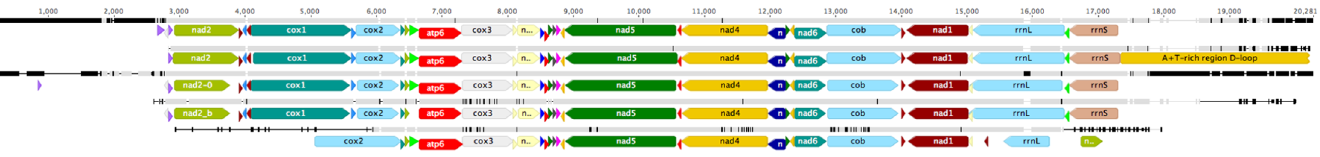
Fig 5. Comparison of the mitogenome sequences of H . axyridis obtained in this work with H . axyridis (KR108208) [38] using standard parameters in MAFFT v7.017 [34]. The KR108208 has 16,387bp, 13 PCGs, 20 tRNAs (missing trn I and trn Q) and 2 rRNAs. The mitogenomes sequencedhere are displayedwith highestsimilarity on top. From the top to the bottom are: the mitogenome obtainedby method 2; KR108208; followedby methods 4, 1 and 3, respectively. The annotated mitogenomes are in color, with arrows representingthe transcriptionalsense of the gene, and small arrows representing tRNA genes. Grey bars represent similar nucleotides and vertical black bars represent dissimilarnucleotides in the target sequencecomparedto the consensus sequence, and horizontalblack lines represent gaps in the target sequence.